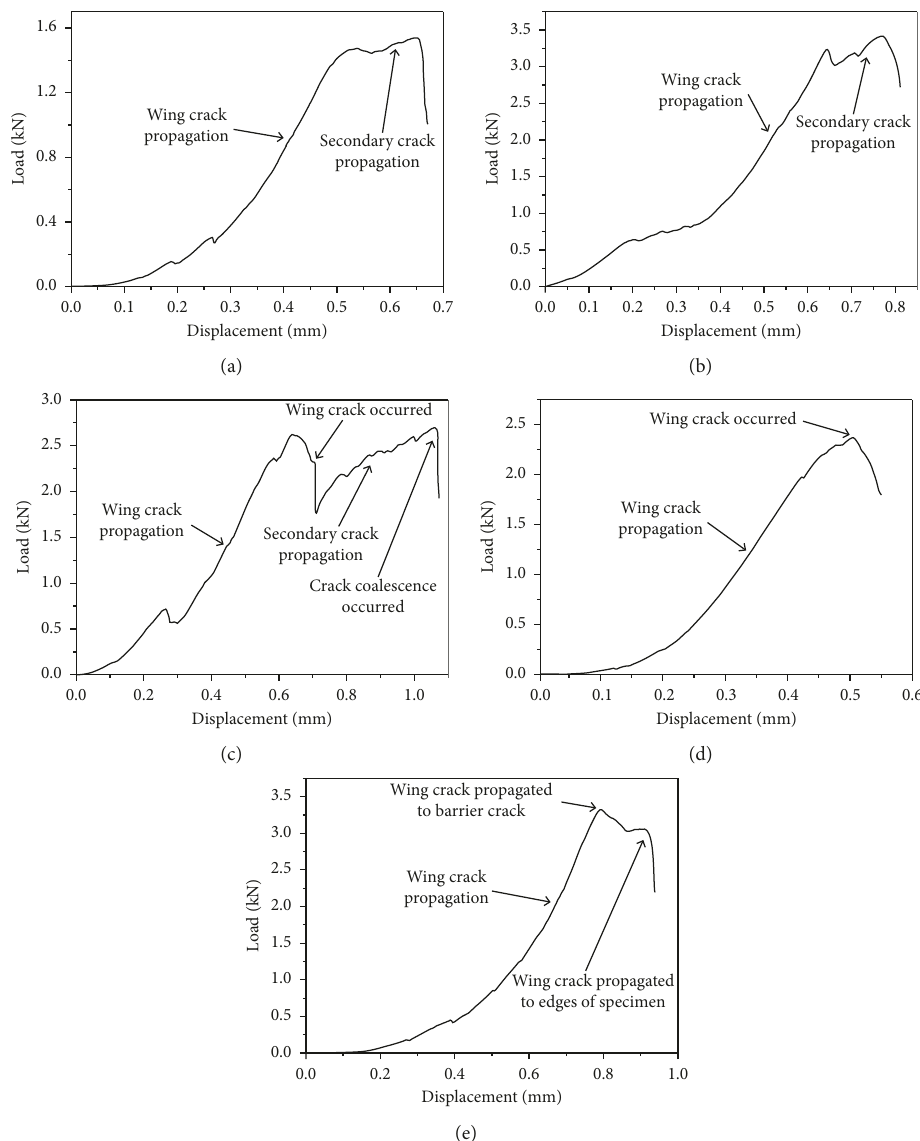
Figure 11: Load-displacement curves of the specimens with different types of crack systems. (a) Forward echelon crack system. (b) Inverse echelon crack system. (c) Two parallel cracks. (d) Three parallel cracks. (e) Crack system with barrier